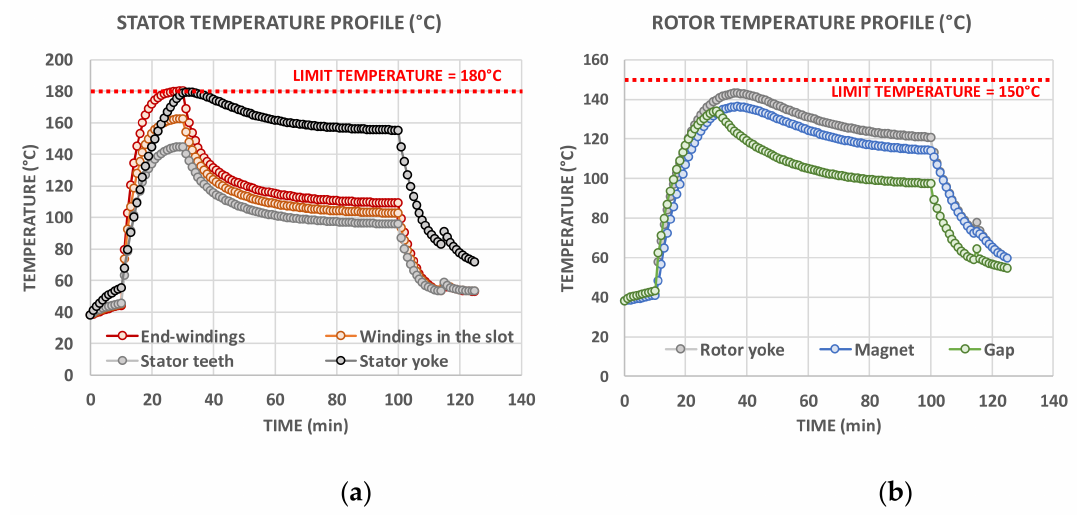
Figure 14. Temperature cycles for “transient-state thermal model”-based optimization: ( a ) stator side, and ( b ) rotor side.